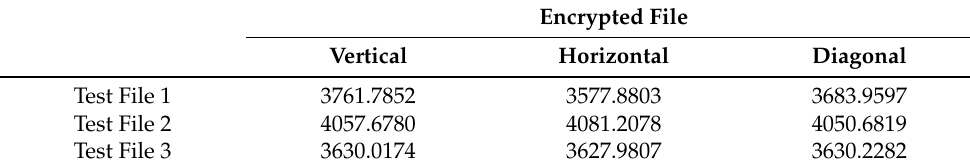
Table 6. MSE values of the image version of the text and the encrypted